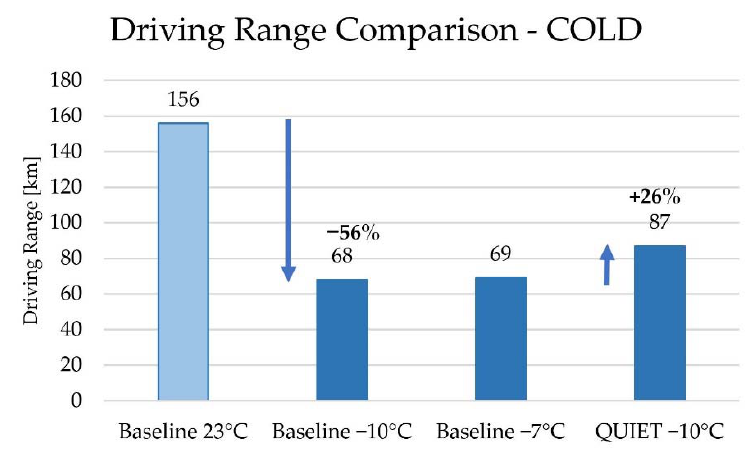
Figure 10 . Driving range comparison at cold ambient temperature.